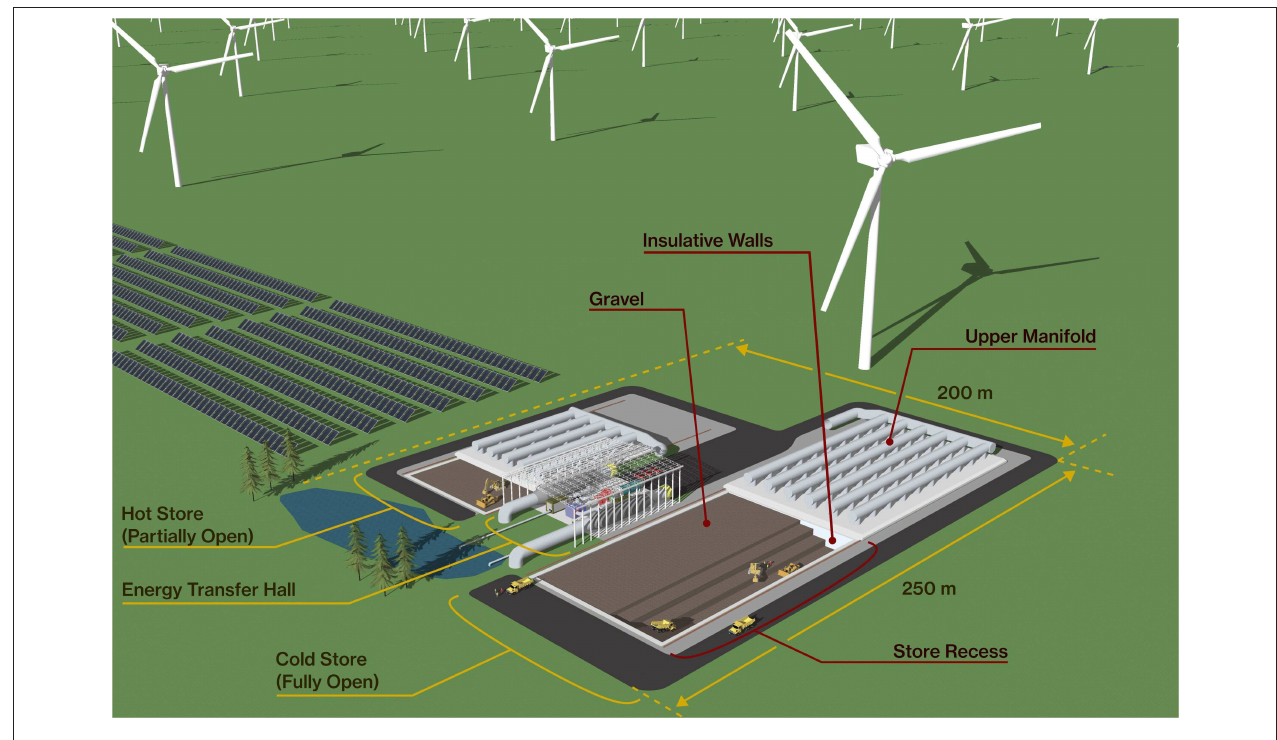
FIGURE 6 | View of the facility shown in maintenance configuration (thermal stores open).